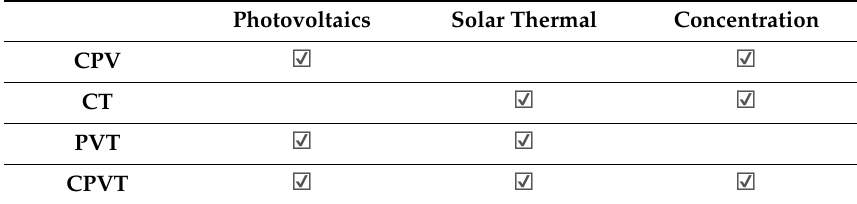
Table 1. Combination of individual solar energy technologies . 71